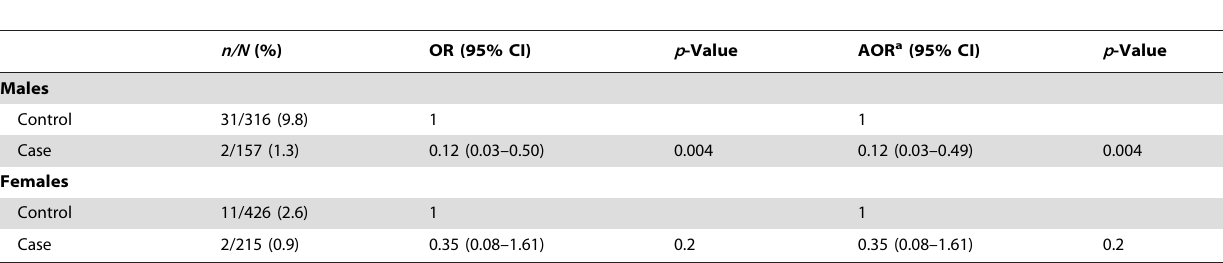
Table 3. Unadjusted ORs and AORs for phenotypic G6PD deficiency stratified by sex.